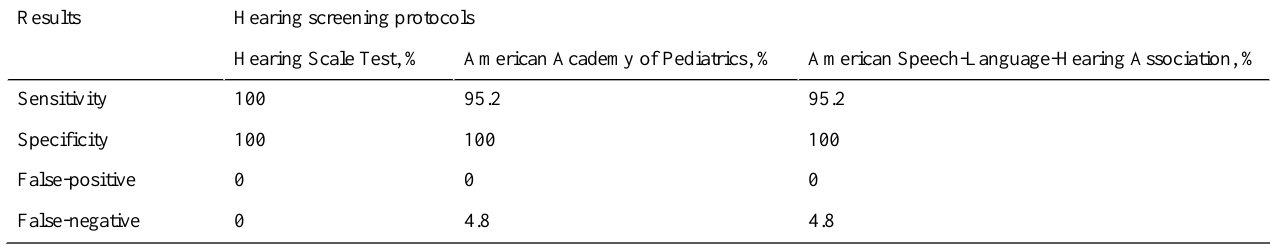
Table 4. Comparison of the hearing screening protocols for both ears of all subjects participating in the study. Hearing screening